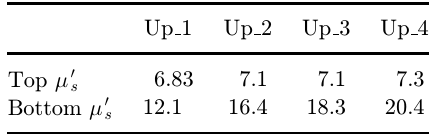
Table 1. (cid:1) 0 s of base-up models (cm (cid:1) 1 ).